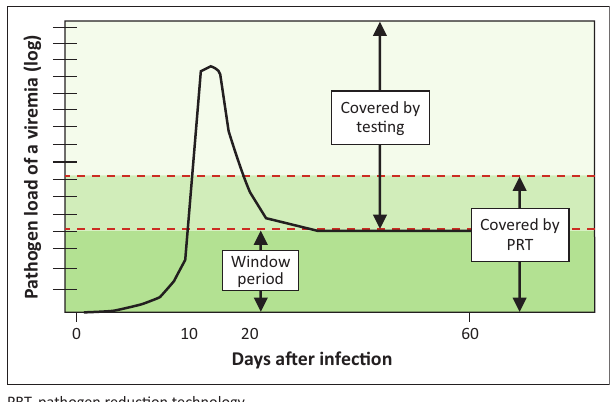
PRT, pathogen reduction technology. FIGURE 5: The principle of combining pathogen reduction technology with existing testing